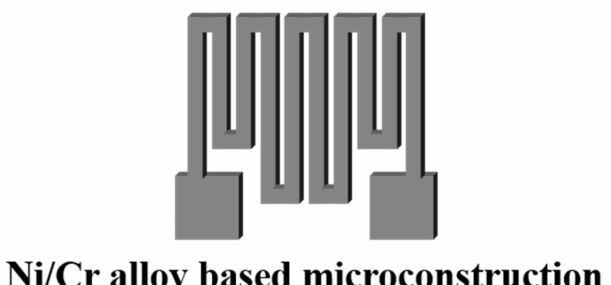
Figure 1. Schematic of meander-type Ni/Cr alloy-based